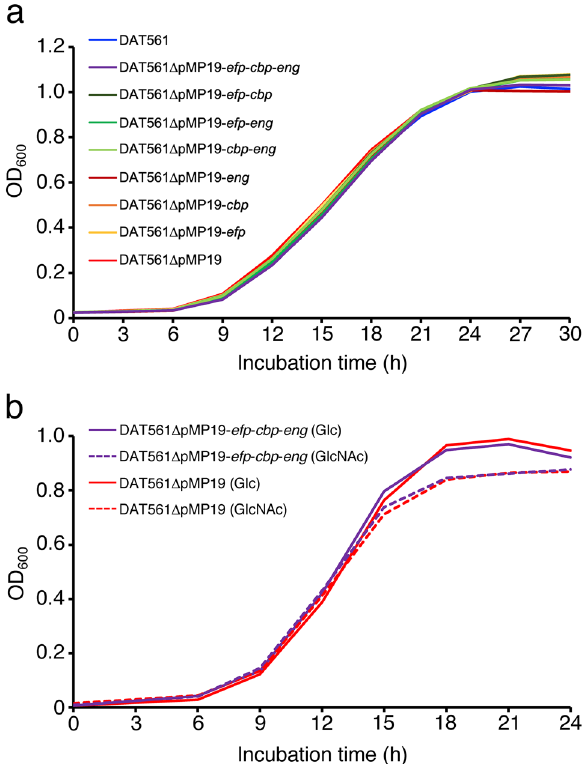
Figure 3. Growth curves of M. plutonius DAT561 and its derivatives in KSBHI broth ( a ) and carbohydrate test media supplemented with glucose (Glc) and N -acetylglucosamine (GlcNAc) ( b ). Growth of each strain in KSBHI broth was measured in duplicate in each test and the tests were repeated twice, whereas growth in carbohydrate test media was measured using five independent culture tubes. Means of the optical density at 600 nm (OD 600 ) are